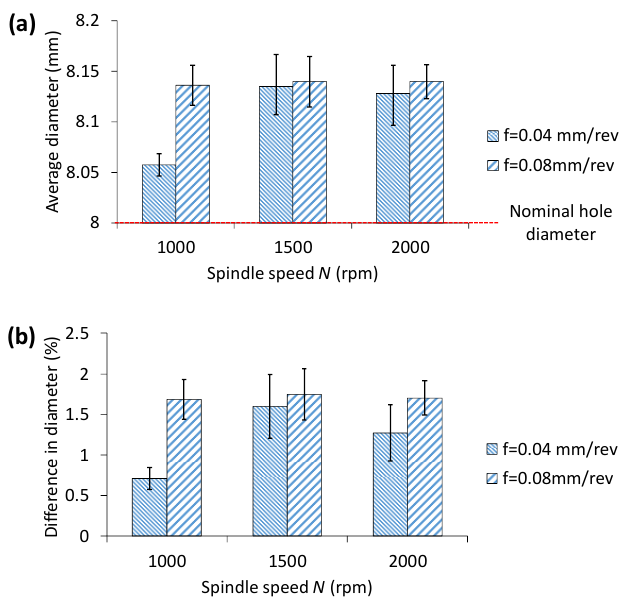
Figure 6. Effect of federate and spindle speed on ( a ) hole diameter and ( b ) % of difference with respect to its nominal size (=8 mm). Error bar indicates standard deviation of hole diameter for drilling of 10 holes.